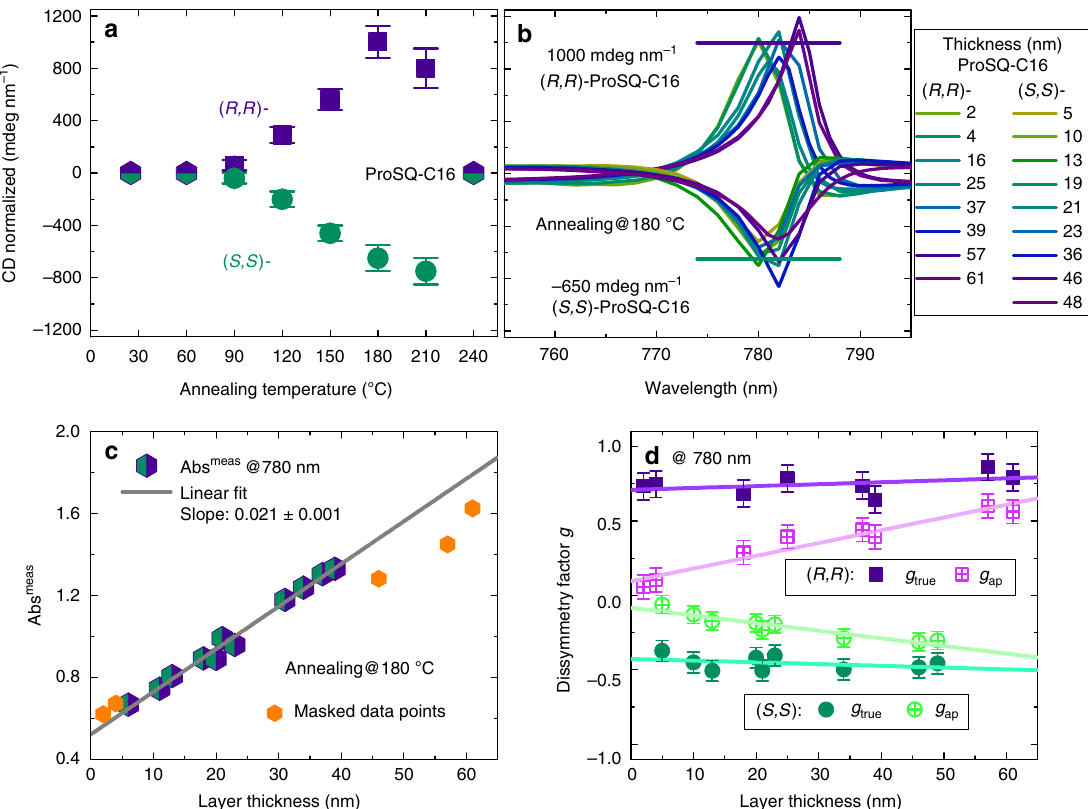
Fig. 6 Thickness and absorbance normalized circular dichroic properties of ProSQ-C16 thin fi lms. a Averaged maximum values of thickness normalized CD for varying annealing temperatures of ( R,R )- and ( S,S )-ProSQ-C16 thin fi lms. The error bars are standard deviations. b Collection of thickness normalized CD spectra for thin fi lms of varying thicknesses annealed at 180 °C. The layer thickness is color-coded as stated in the legend. c Unpolarized absorbance Abs meas vs. layer thickness. Data are peak values at around 780 nm from samples annealed at 180 °C. The unpolarized absorbance is valid for both enantiomers. From the linear fi t of Abs according to Eq. (7) the re fl ection corrected absorbance Abs cor is calculated. d Maximum apparent and true dissymmetry factors g ap and g true according to Eqs. (6) and (8), respectively, at 780 nm against layer thickness for samples annealed at 180 °C. Straight lines in c and d are linear fi ts to the data points. Data in b and d are from the same samples and thus are convertible. Error bars are inferred from the experimental uncertainties of the measurements and are not standard